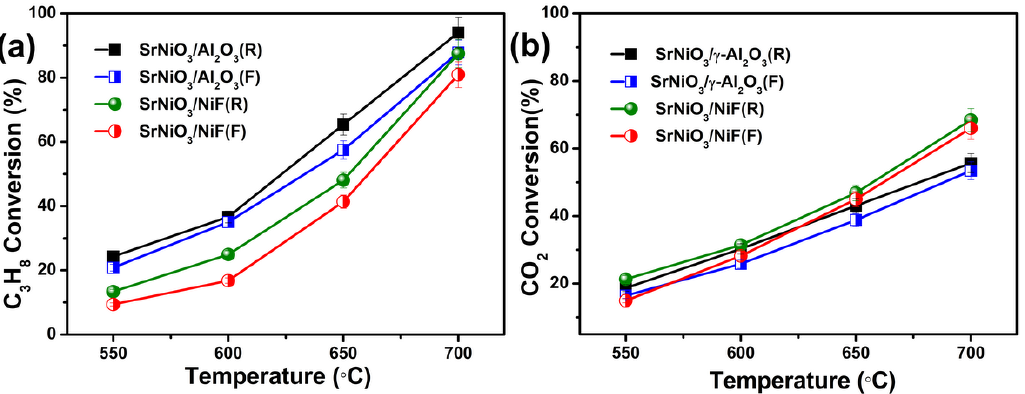
Figure 6. Catalytic activity of dry reforming of propane (DRP) as a function of temperature over SrNiO 3 / γ -Al 2 O 3 (F and R) and SrNiO 3 /NiF (F and R) catalysts at 550 ◦ C to 700 ◦ C under atmospheric pressure in CPR = 3 (30:10:60 CO 2 :C 3 H 8 :Ar) and total flow rate = 200 mL/min ( a ) C 3 H 8 conversion ( b ) CO 2 conversion.